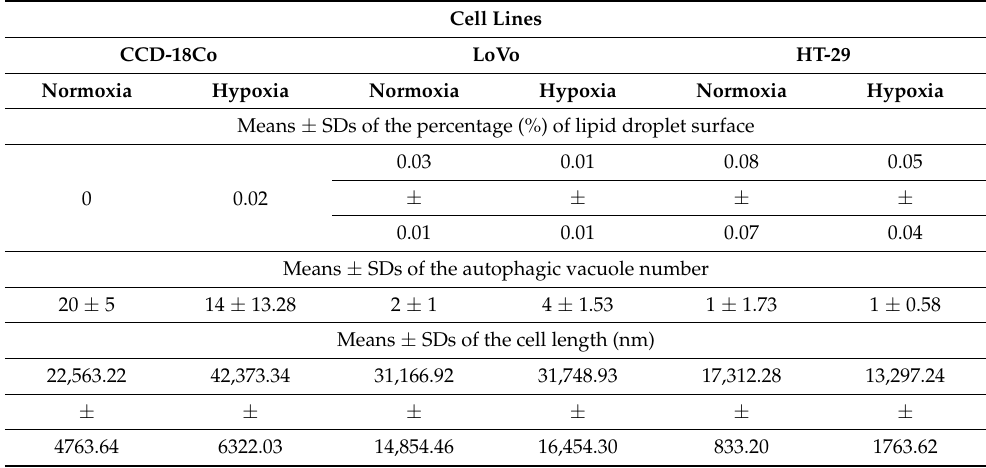
Table 1. TEM quantitative assessment of morphometric and subcellular patterns of the human non-neoplastic and cancer cells of colonic epithelium appearing in different oxygenation conditions (n = 3 cells/oxygen environment in each